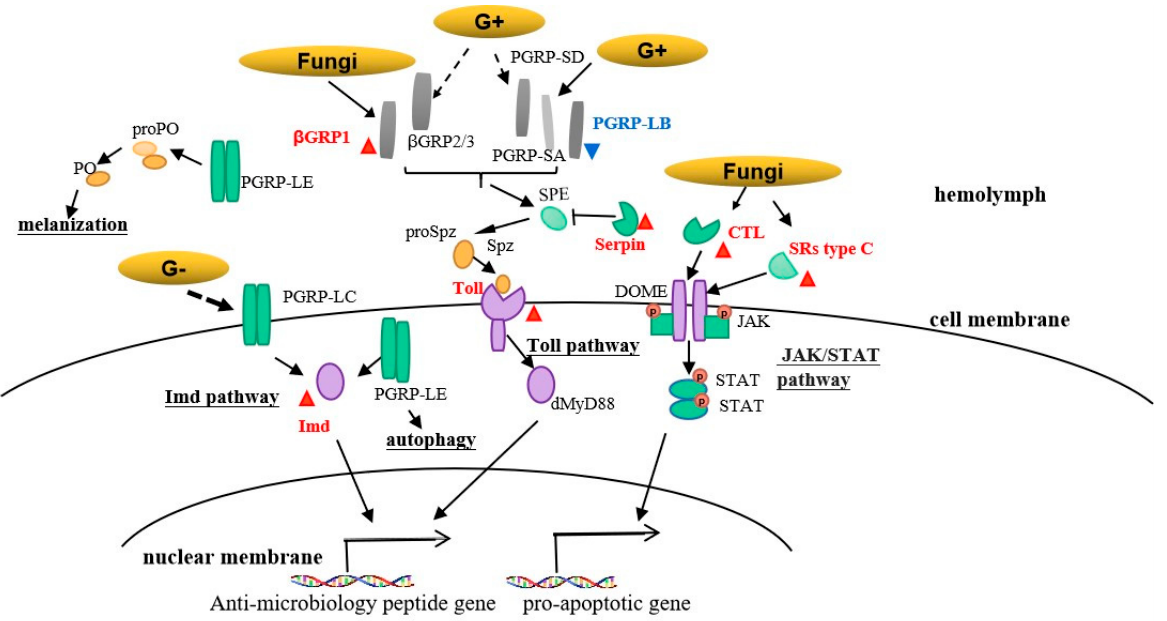
Figure 8. The putative pathways, on the basis of Drosophila research, mediate the response to pathogen infection. The component of the fungal cell wall is sensed by circulating β GRP, peptidoglycan recognition proteins (PGRPs, e.g., PGRP-SA, PGRP-SD and PGRP-LB), a process that activates a proteinase-signaling cascade followed by cleavage of the proSpz (ProSpaetzle) to mature Spz (Spaetzle), binds with Toll, which causes aggregation of intracellular proteins, e.g., MyD88, leading to expression of anti-microbiology peptide (AMP) genes; with the response to the pathogen components, C type lectin (CLT) and/or scavenger receptors (SRs type C) activates JAK/STAT signaling pathway, leading to the expression of pro-apoptotic genes; PGRP-LE in hemolymph activates the prophenoloxidase (proPO) cascade followed by cleavage of the proPO to mature phenoloxidase PO, leading to the melanization for fungi infection; PGRP-LE in cytoplasm activates autophagy-mediated immunity defense; with the responses to fungal infection, PGRP-LC activates Imd pathway, leading to the expression of AMP genes. ‘-’ indicates the name of pathway, the red triangles and letters represent ‘upregulated’ proteins in IL compared to L; the blue triangle and letters represent the ‘downregulated’ protein in IL compared to L.